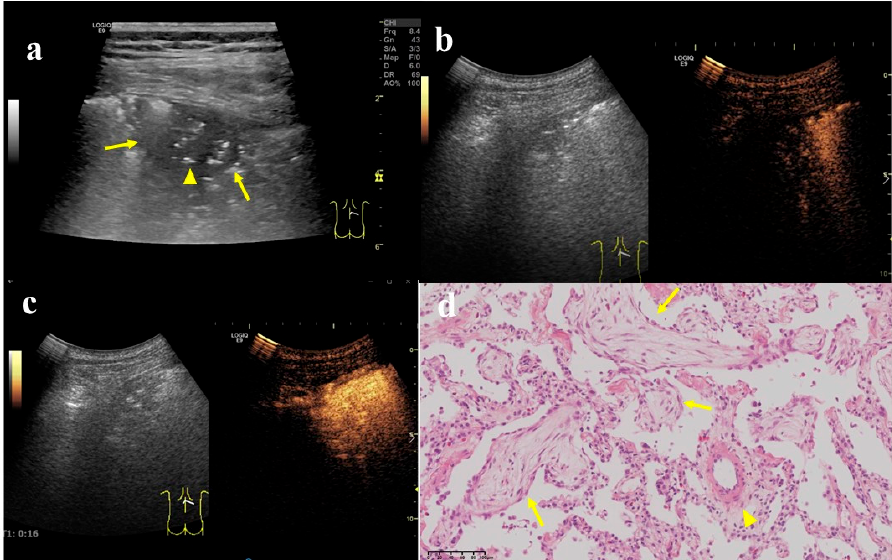
Table 1. Patient demographic and clinical characteristics.